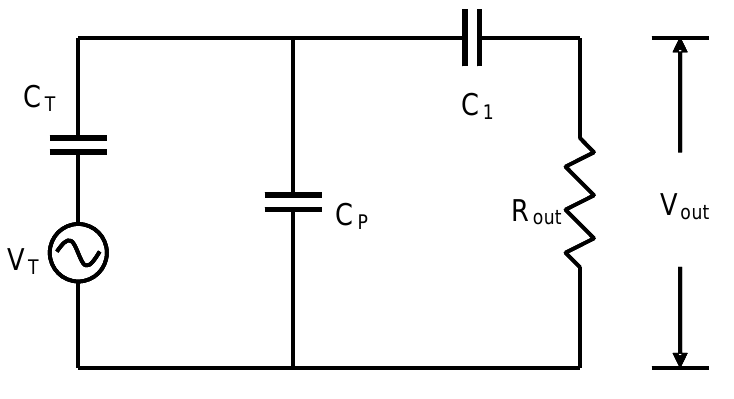
Figure 3. Circuit model to simulate the effect of parasitic